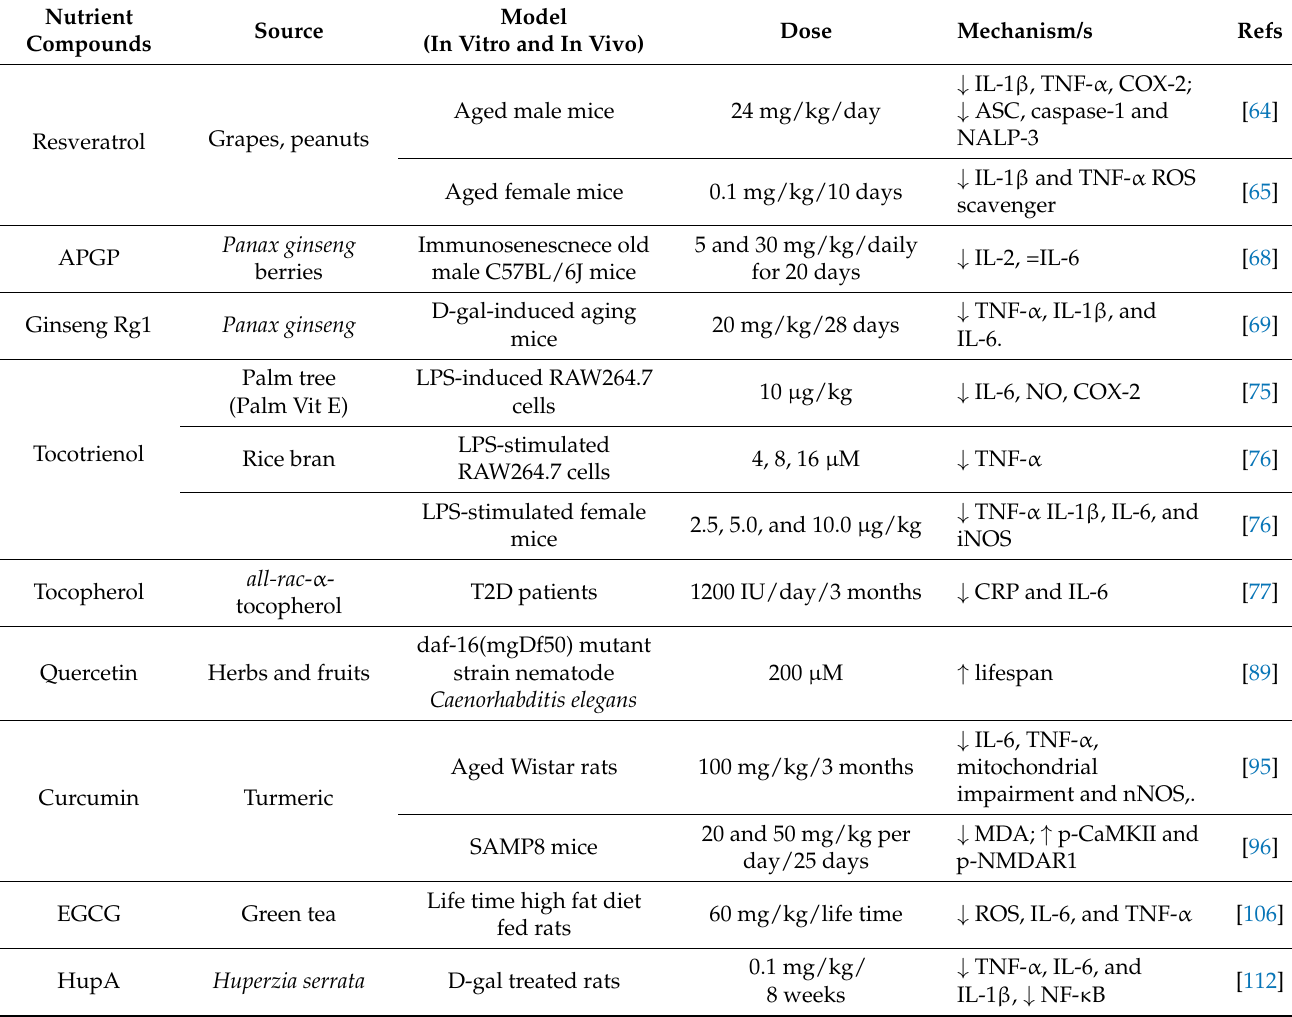
Table 1. Selected nutrients from natural and synthetic sources targeting inflammaging in experimental models.